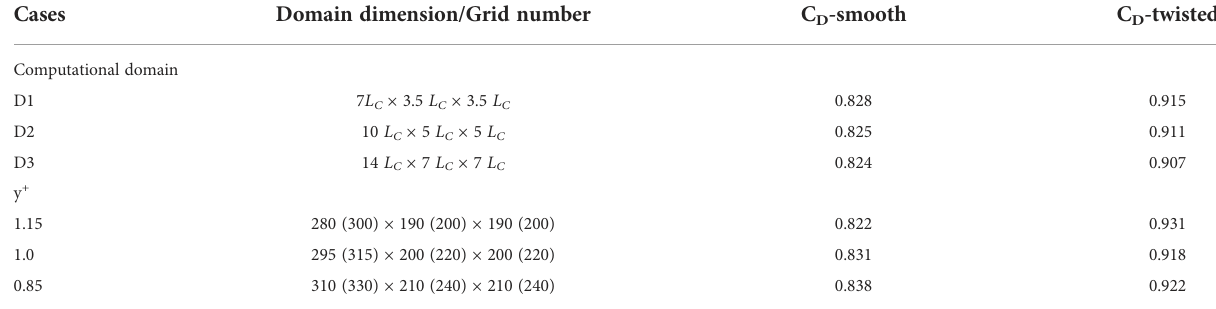
TABLE 3 Grid independent study at different domains and y + . Cases